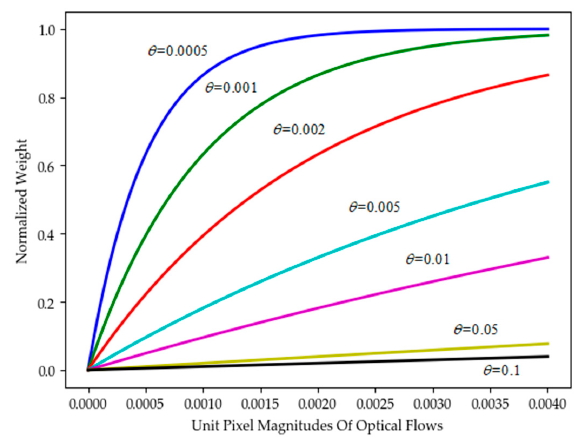
Figure 3. Correlation between normalized weight and unit pixel magnitudes of optical flows with di ff erent parameters θ